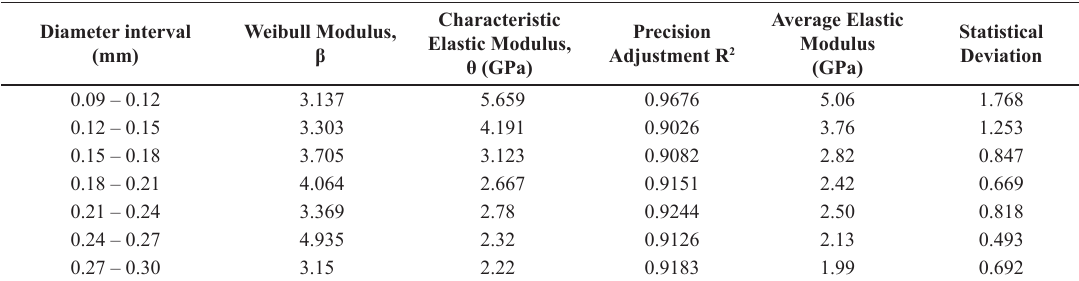
Table 1. Weibull parameters for the average elastic modulus of fique fibers associated with different diameter